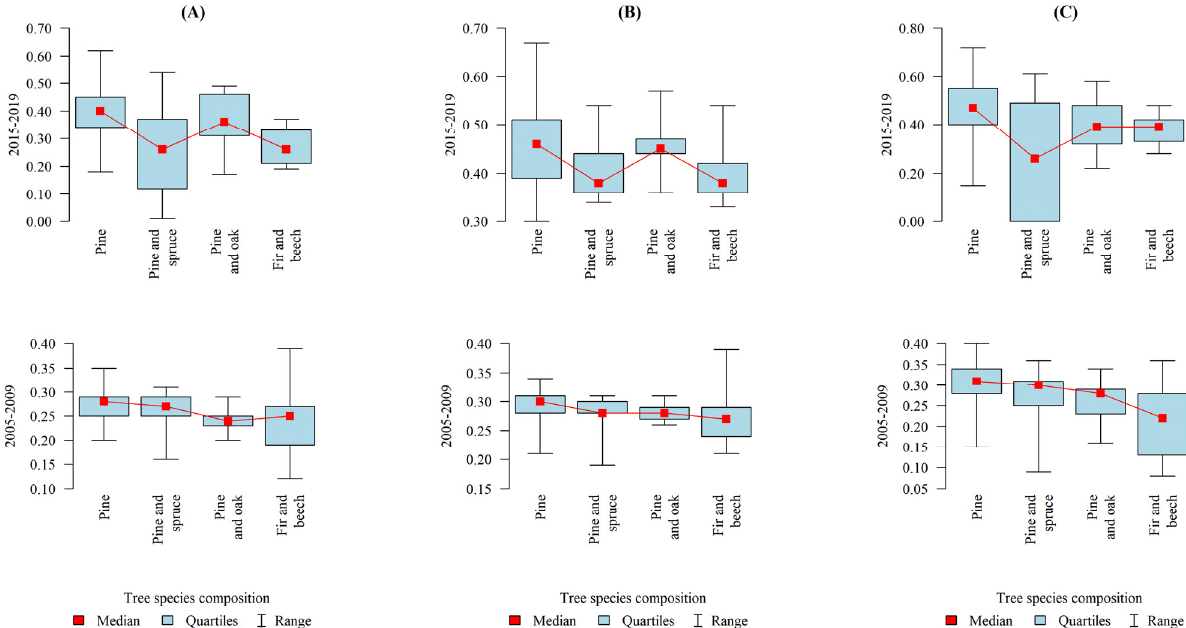
Figure 4. Ranges, medians, and quartiles of synthetic financial indicators 1, 2, and 3 for tree species composition. ( A ) syn-